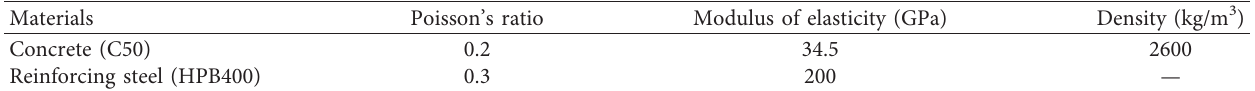
Table 7: Concrete and reinforcement material parameters.